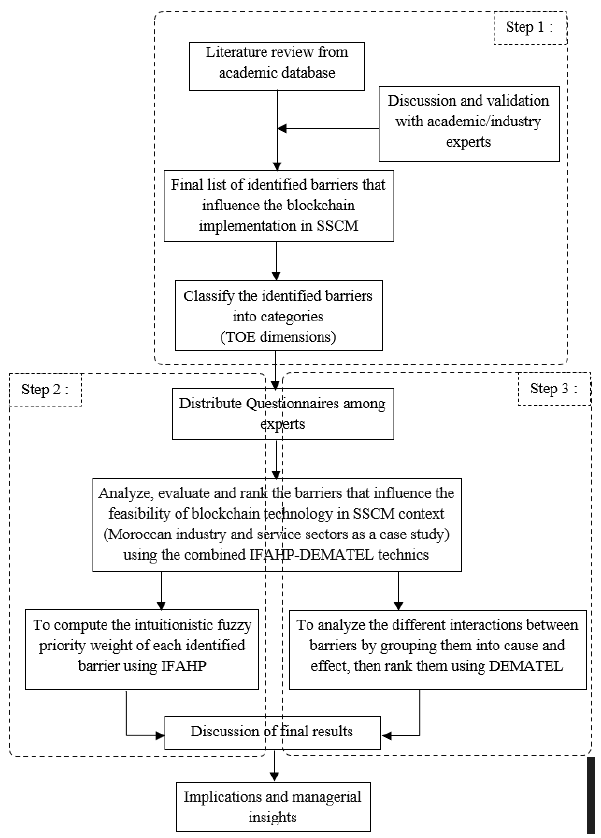
Figure 1. Proposed fuzzy group decision-making